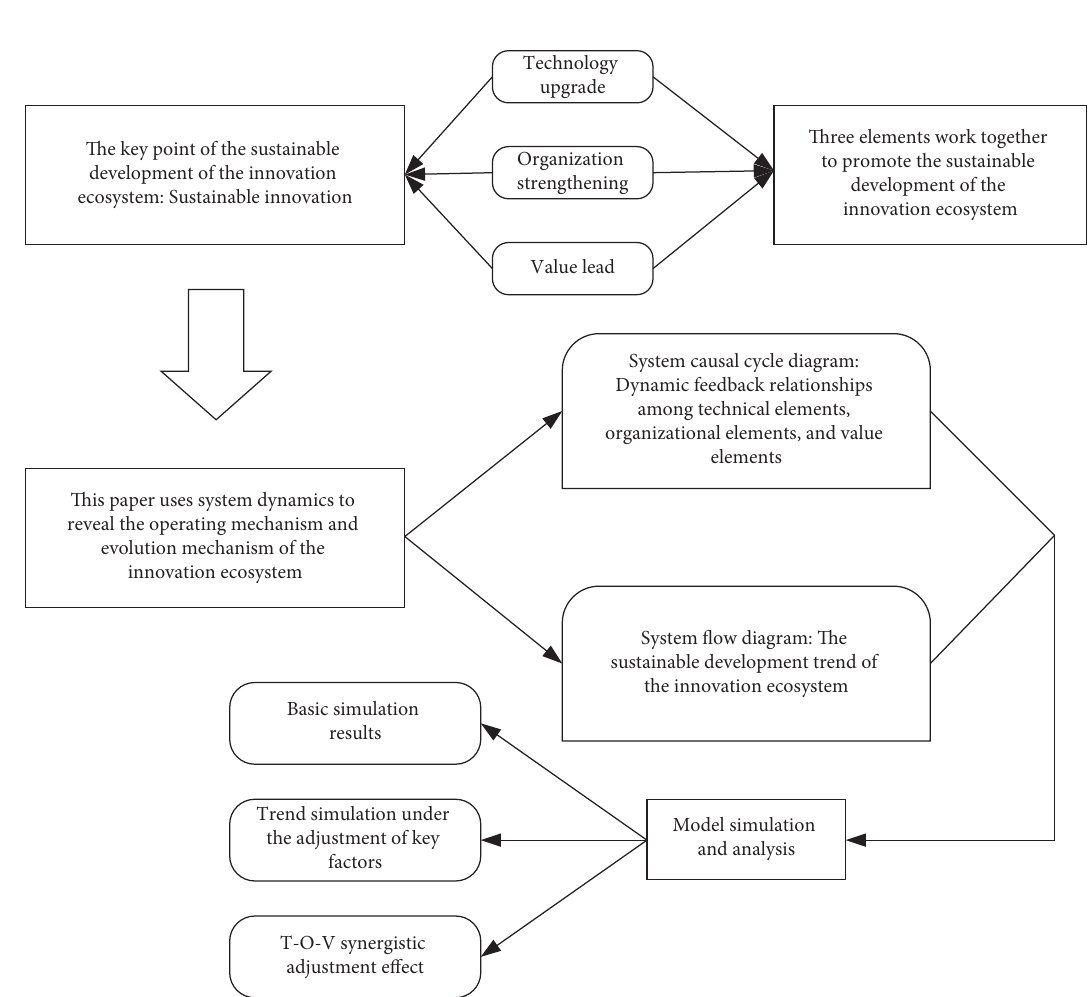
Figure 1: Research